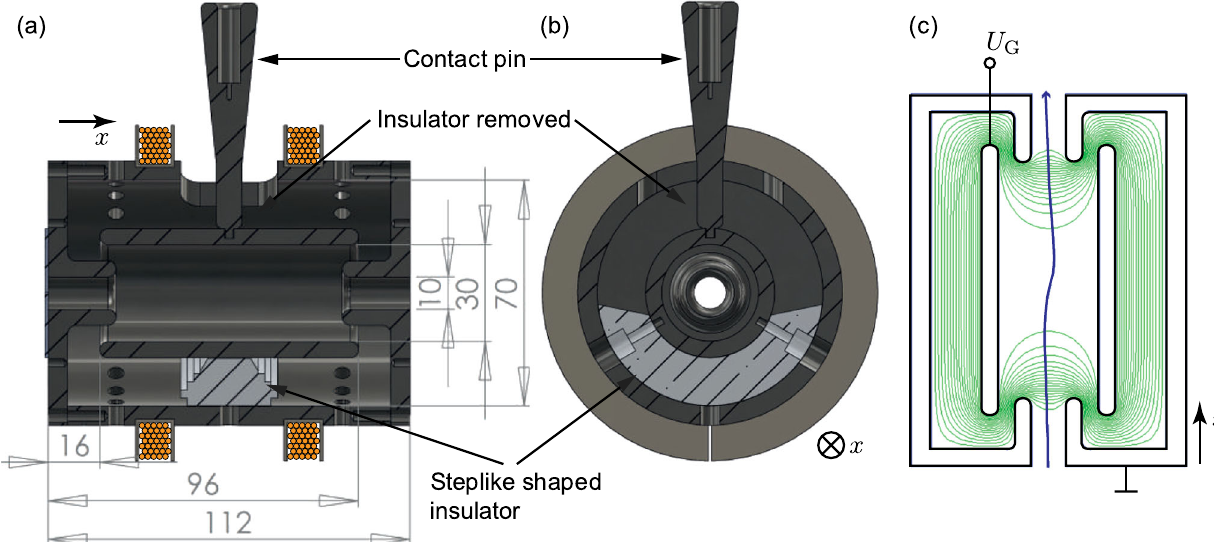
FIG. 7 (color online). (a,b) Sectional views of the electrostatic filter lens with dimensions in mm. We use stainless steel electrodes (dark gray). The vespel insulator (light gray) has been designed following the example of [38,39]. Multiple steps near the cathode collect emitted electrons, resulting in a space charge that lowers the surface electric field at the cathode and reduces electron emission [38]. The two circular u profiles are coiled with wires (orange circles) to apply an axial magnetic field, which we did not use during the experiment ¼ − 28 : 2 kV as it distorted the electron beam focus at the grating. (c) Charged particle optics (CPO) simulation of the filter lens for U G with the electrodes (black lines), equipotential surfaces (green lines), and a sample trajectory of a 28 keVelectron (blue). From the CPO simulation we infer an offset between the applied voltage U and the potential barrier at the center of the filter lens of 260 V due to field G penetration, which is why the electron still passes for the given numbers.